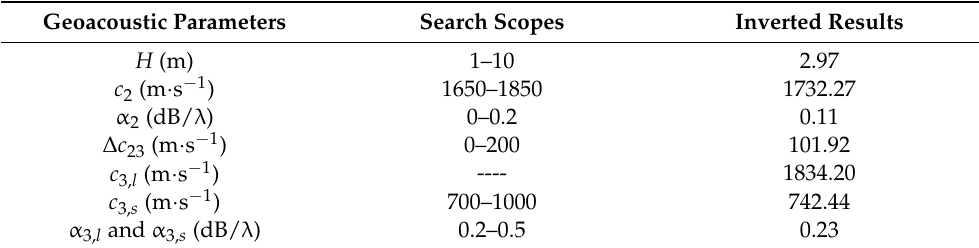
Table 1. Search scopes of geoacoustic parameters for proposed bottom model and inverted